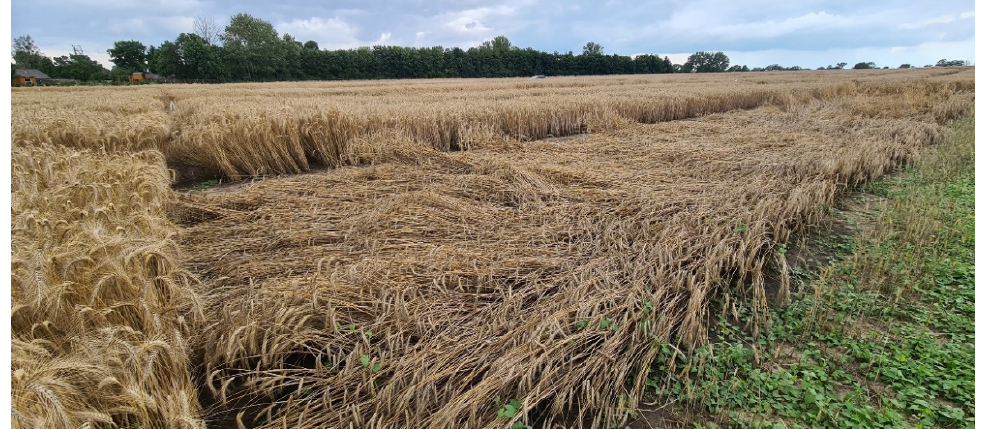
Figure 11. Genetic growth regulation by the major dwarfing gene Ddw1 confers pronounced lodging resistance. The displacement of culms from an upright position of the near-isogenic conventional experimental hybrids in the foreground subsequent to extreme precipitation of 200 L/m 2 could not be prevented although they were treated with chemical plant growth regulators.